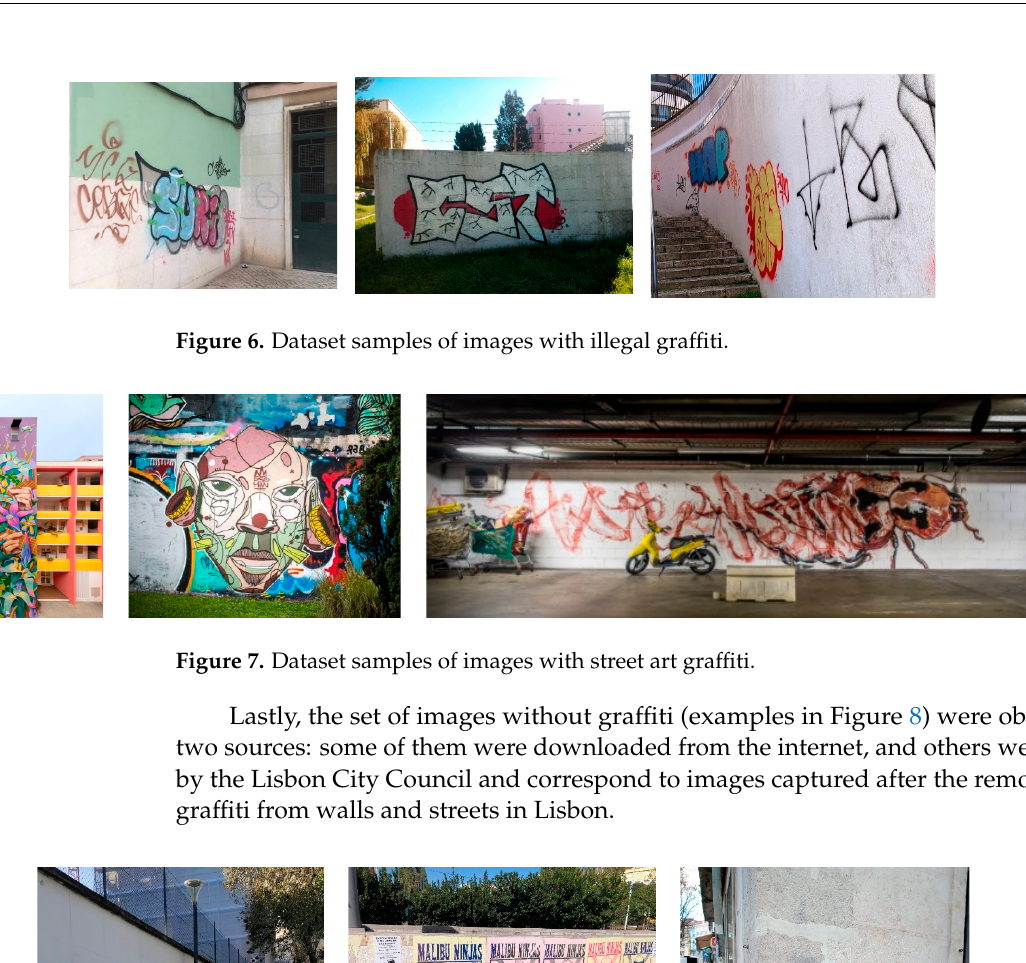
Figure 7. Dataset samples of images with street art graffiti.